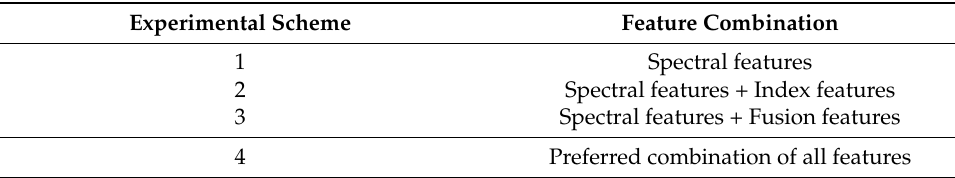
Table 3. The information of experimental schemes. Experimental